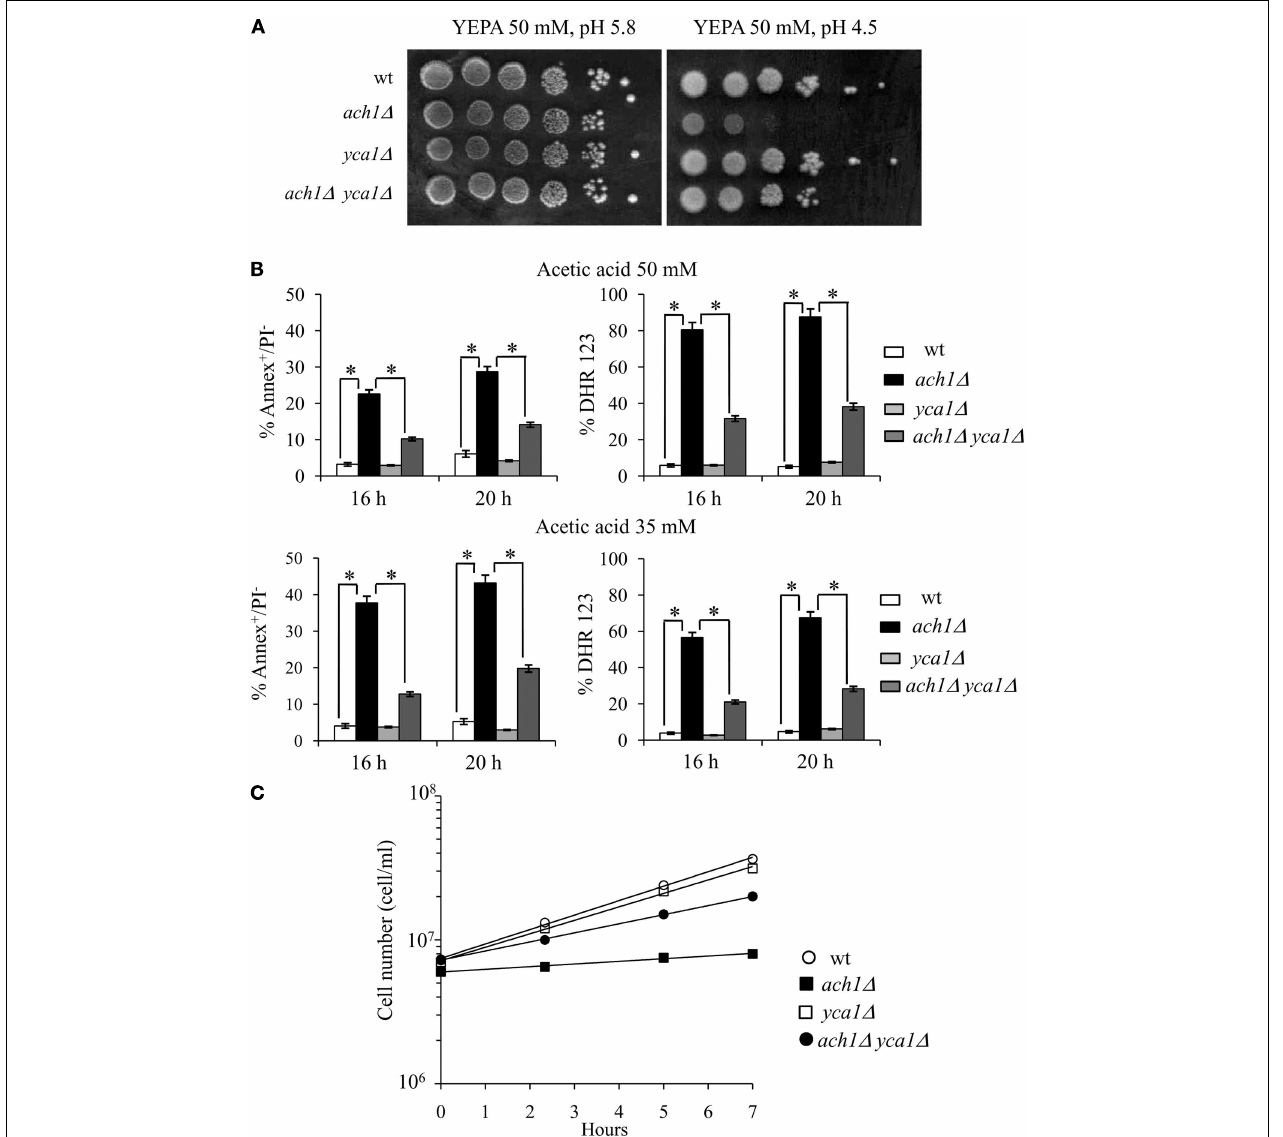
and stained with DHR123 for the presence of intracellular ROS. Summary graphs of the percentage of AnnexinV + /PI − and of ROS-accumulating cells are reported. Evaluation of about 500 cells for each sample in three independent experiments was performed. Standard deviations are indicated. Statistical significance between the strains is indicated ( ∗ P ≤ 0.001, Student’s t -test). (C) Growth curves of the indicated strains grown in 35mM